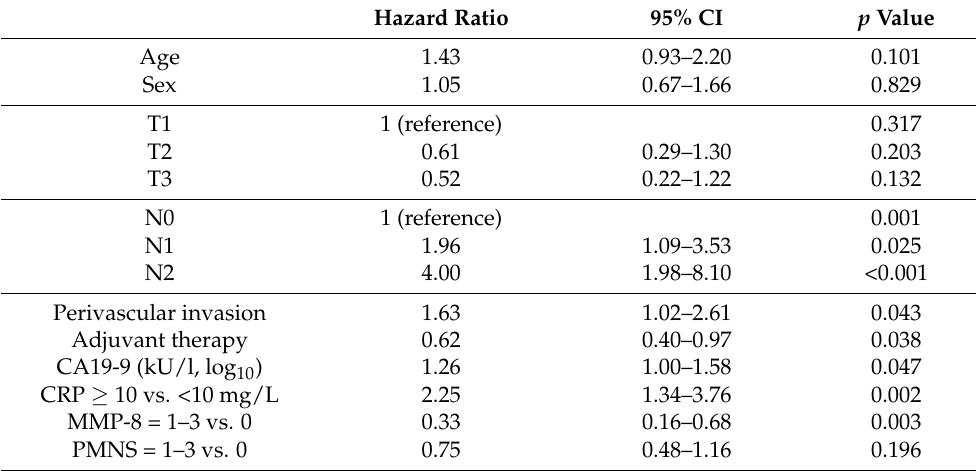
Table 3. Multivariable analysis of the relative risk of death from pancreatic ductal adenocarcinoma (PDAC) by matrix metalloproteinase 8 (MMP-8) expression level in cancer cells, tumour-associated MMP-8 positive polymorphonuclear cells (PMNs) and plasma C-reactive protein (CRP) and clinico- pathological characteristics. Hazard Ratio 95% CI p Value